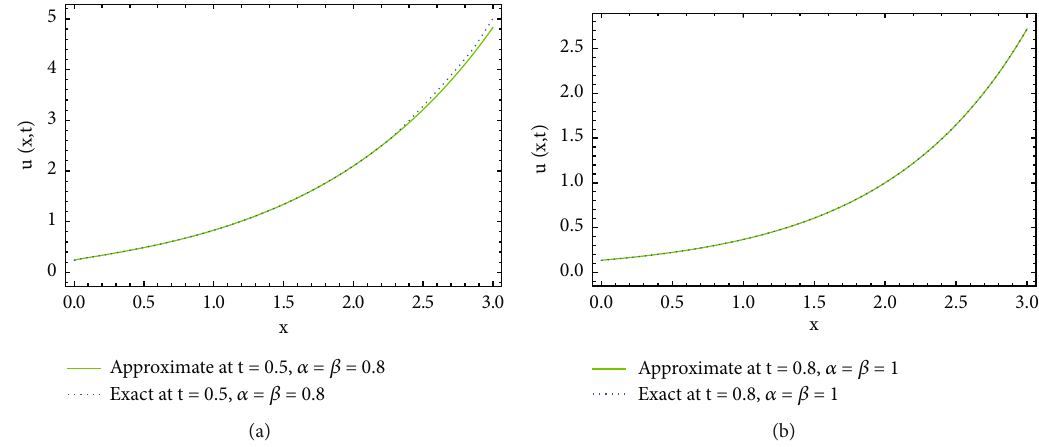
Figure 6: 2D solution plots of Example 2 obtained by the present method in comparison with the exact solutions for di ff erent values of fractional orders α and β